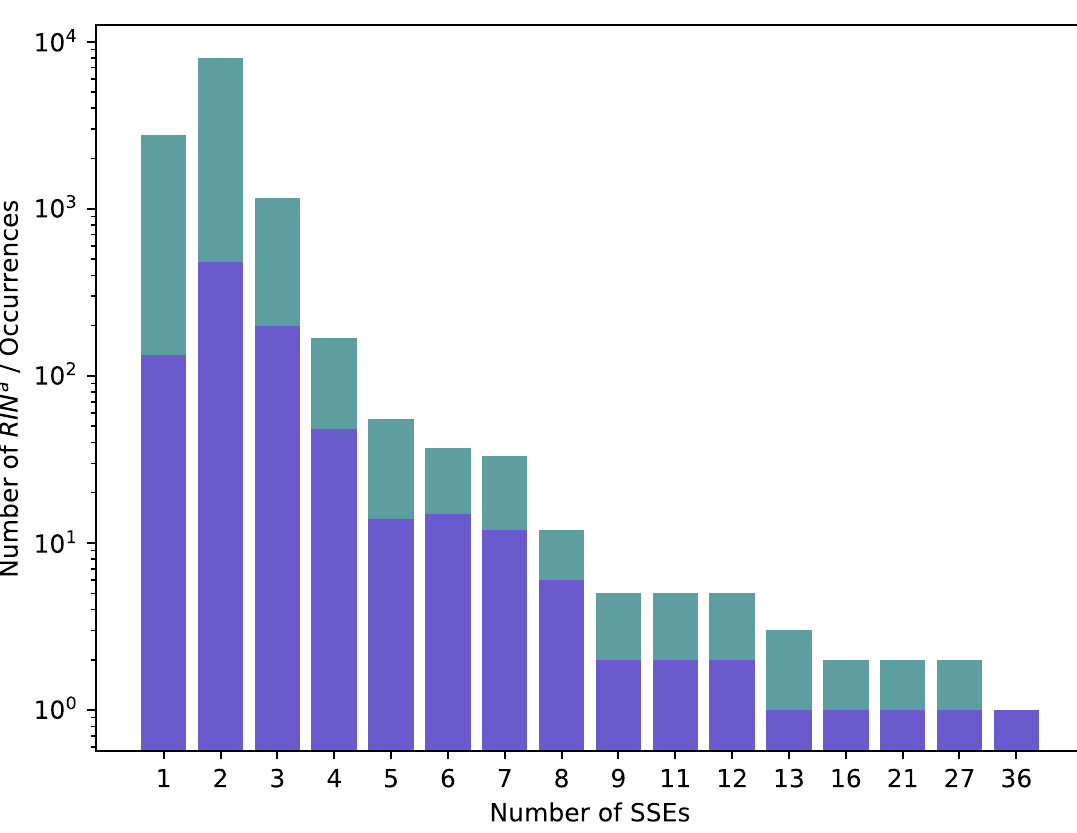
Table 3. Variation in the number of SSEs over the occurrences of the same RIN a . (Cf. Table 2). Those numbers show that the variation in the number of SSEs amongst the occurrences of a given RIN a is both uncommon and limited, even more than with RIN ab , albeit slightly (82% of RIN a Variation in number of